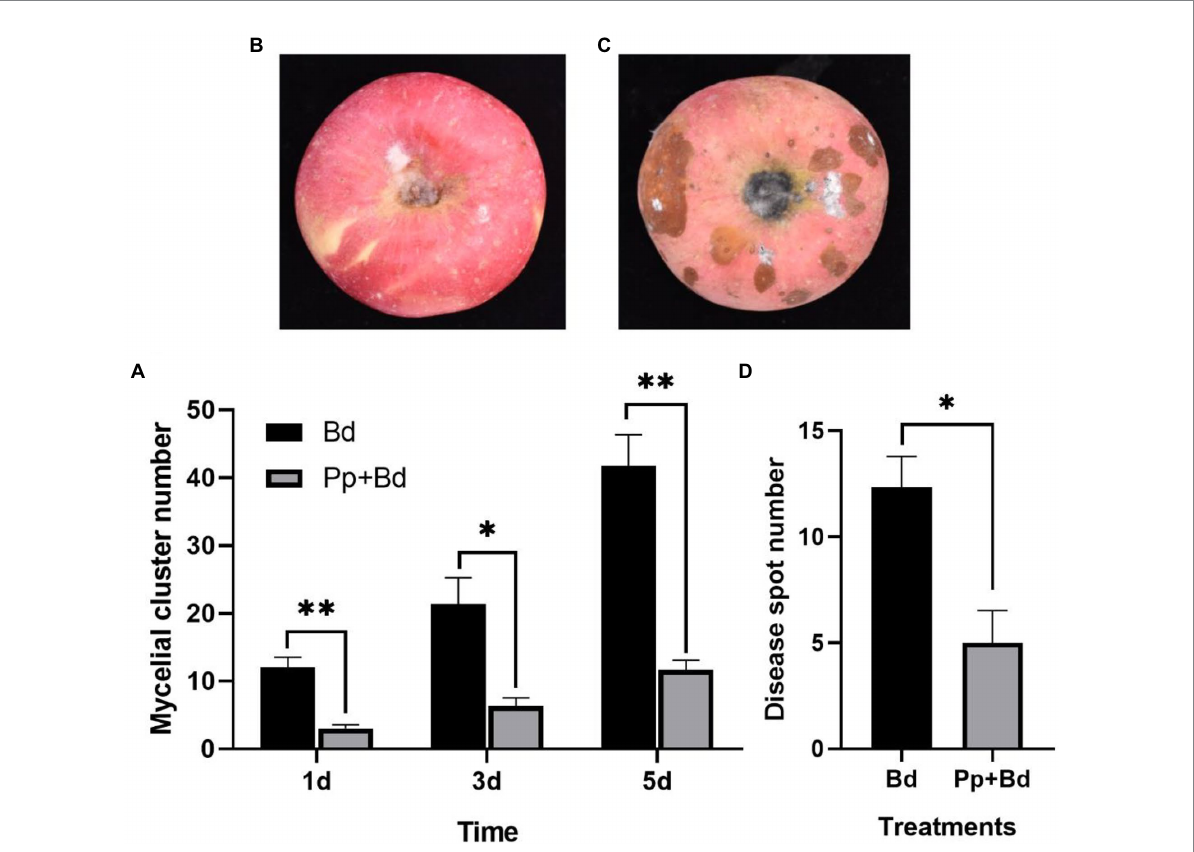
FIGURE 4 The inhibitory effect of P. protegens on apple ring on postharvest fruit (Experiment 2). The mycelial cluster number on P. protegens -treated fruits was significantly smaller than the control on the first, third, and fifth day (A) . In addition, the disease spots on the P. protegens- treated fruits (B) were smaller than that on the control fruits on the seventh day (C) , and the number of the disease spots on the P. protegens- treated fruits was also significantly lower than the control (D) . * p < 0.05, ** p <